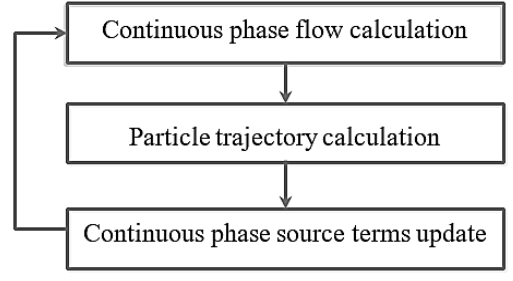
Figure 6. Coupling scheme